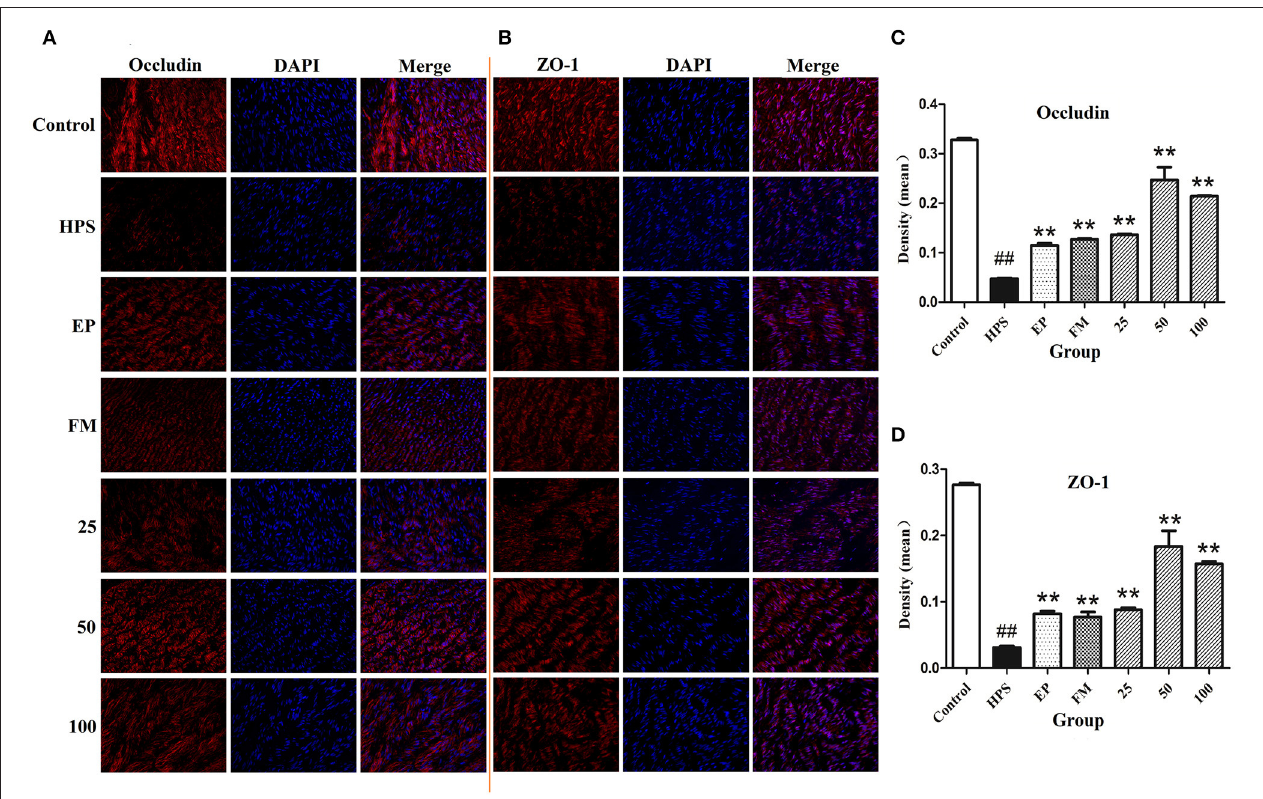
FIGURE 2 | Effects of baicalin on distribution of occludin (A) and ZO-1 (B) in aorta of piglets challenged with G. parasuis (magnification 10 × 40). Fluorescence of occludin (C) and ZO-1 (D) was measured using Image J. HPS: G. parasuis group, EP: EP + G. parasuis group, FM: FM + G. parasuis group, 25: 25 mg/kg baicalin + G. parasuis group, 50: 50 mg/kg baicalin + G. parasuis group, 100: 100 mg/kg baicalin + G. parasuis group. ## p < 0.01 vs. control, ** p < 0.01 vs. G. parasuis